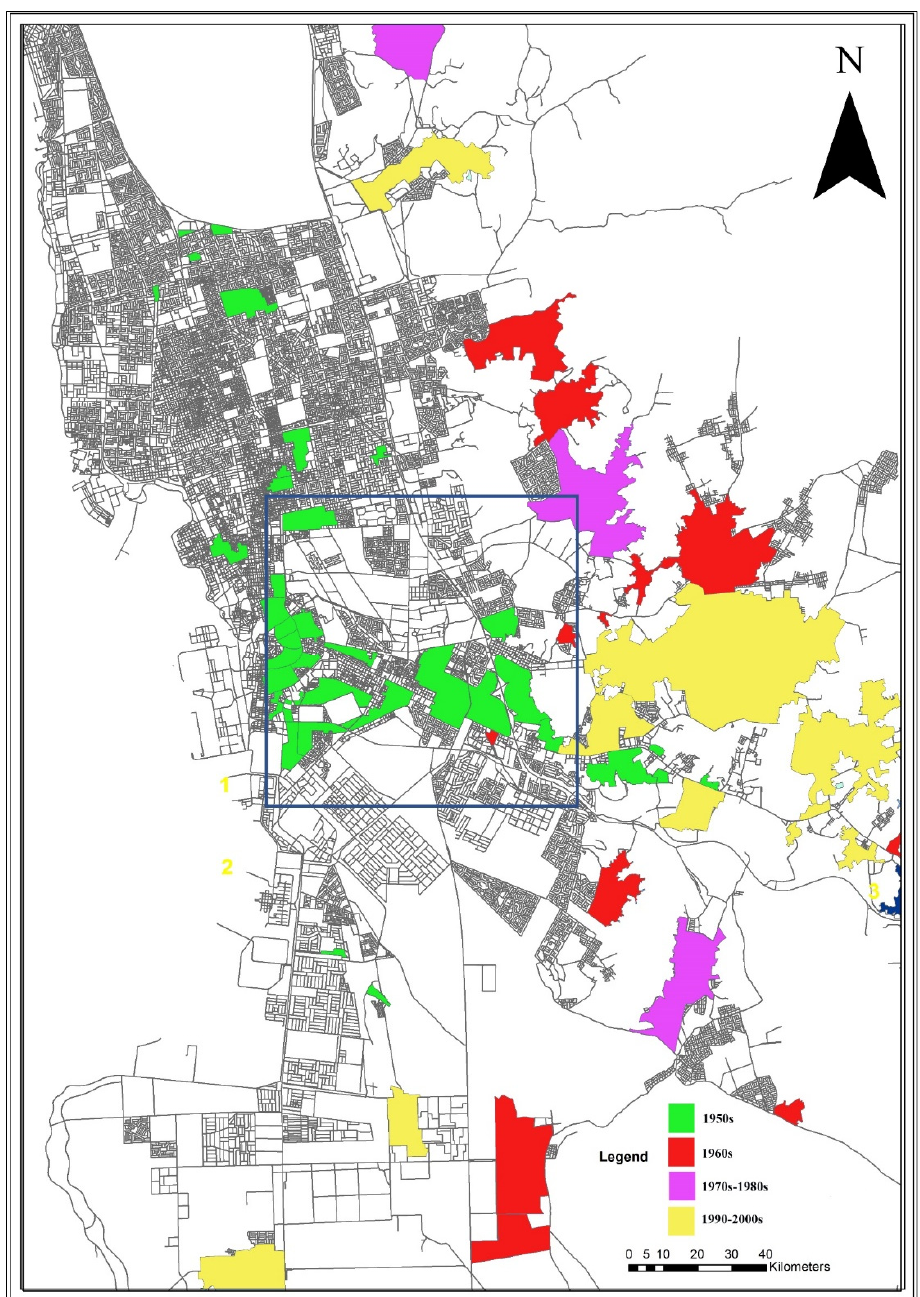
Figure 1. From the earliest informal settlement around the city centre (shown in green), via red and purple, to the most recently populated (yellow), the distribution of informal settlements based on Jeddah Municipality.